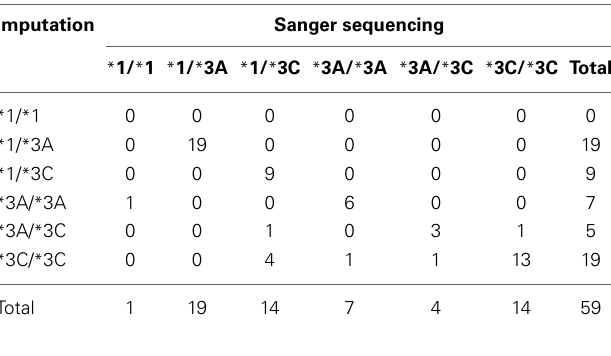
Table 6 | Concordance between imputed genotypes and genotypes determined by Sanger sequencing ( N = 59).